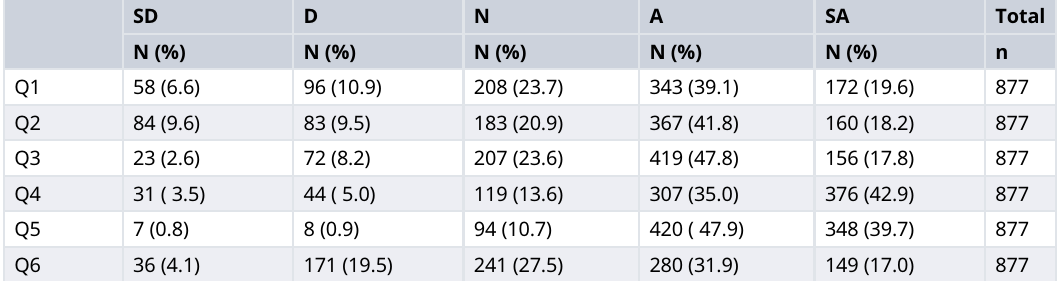
Table 4. Specific responses in percentage to each question ranging from SA (Strongly agree), A (Agree), N (Neutral), D (Diasagree) to SD (Strongly